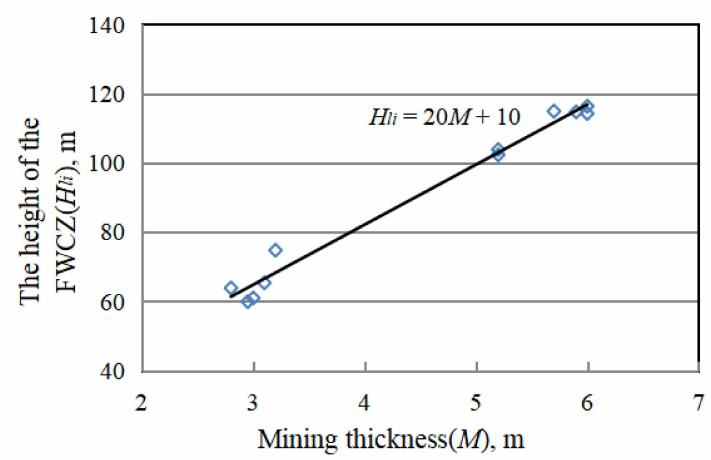
Figure 8. Relationship between height of FWCZ and mining